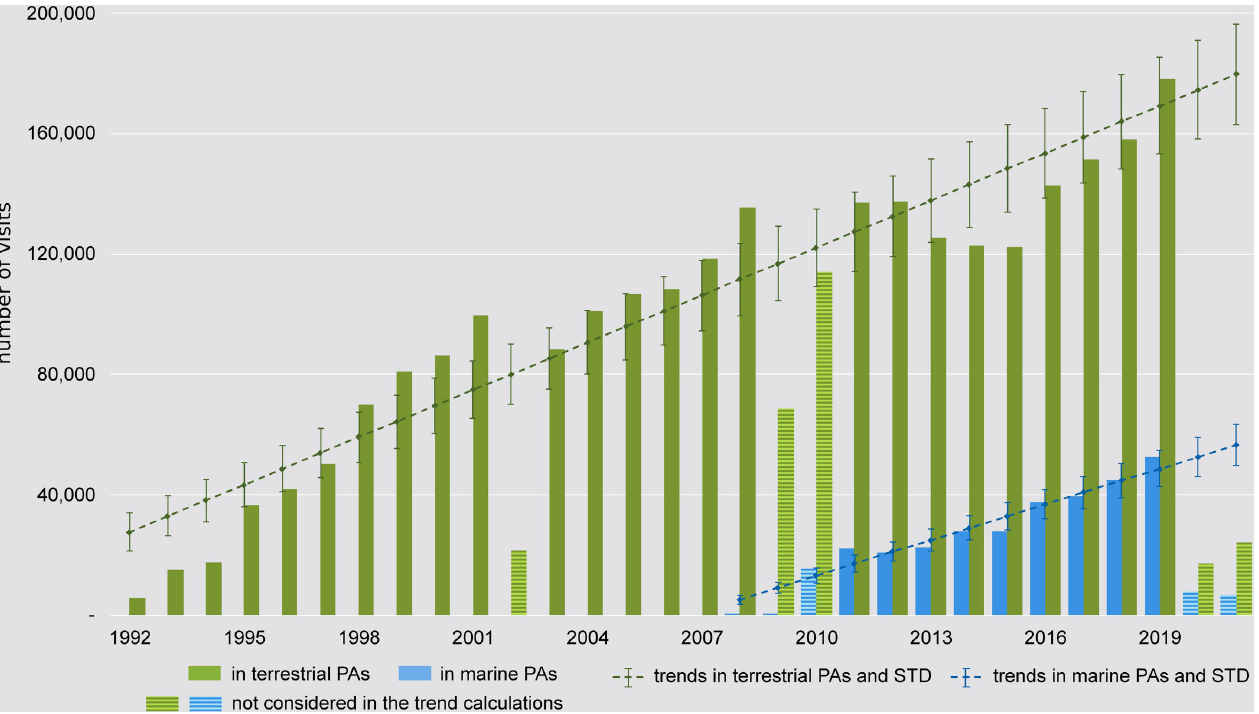
Fig 2. Park entries. Total number of visits in parks and reserves managed by MNP and trend lines calculated for both terrestrial protected areas and marine protected areas. Trend line for terrestrial PAs: number of visits = 5,246 * (year—1991) + 22,354 (r 2 = 0.90); for marine PAs: number of visits = 3,952 * (year— 2010) + 13,090 (r 2 = 0.93); 2002, 2009–2010, and 2020–2021 are not considered in the estimation of the trends as they are years of political instability and in the case of 2020 and 2021 the COVID-19 pandemic; despite the financial crisis end of 2008, the year 2008 is regarded as a “normal” considering that visitors to Madagascar plan their travel well ahead of time, and number of visitors to PAs has not declined by the end of 2008).